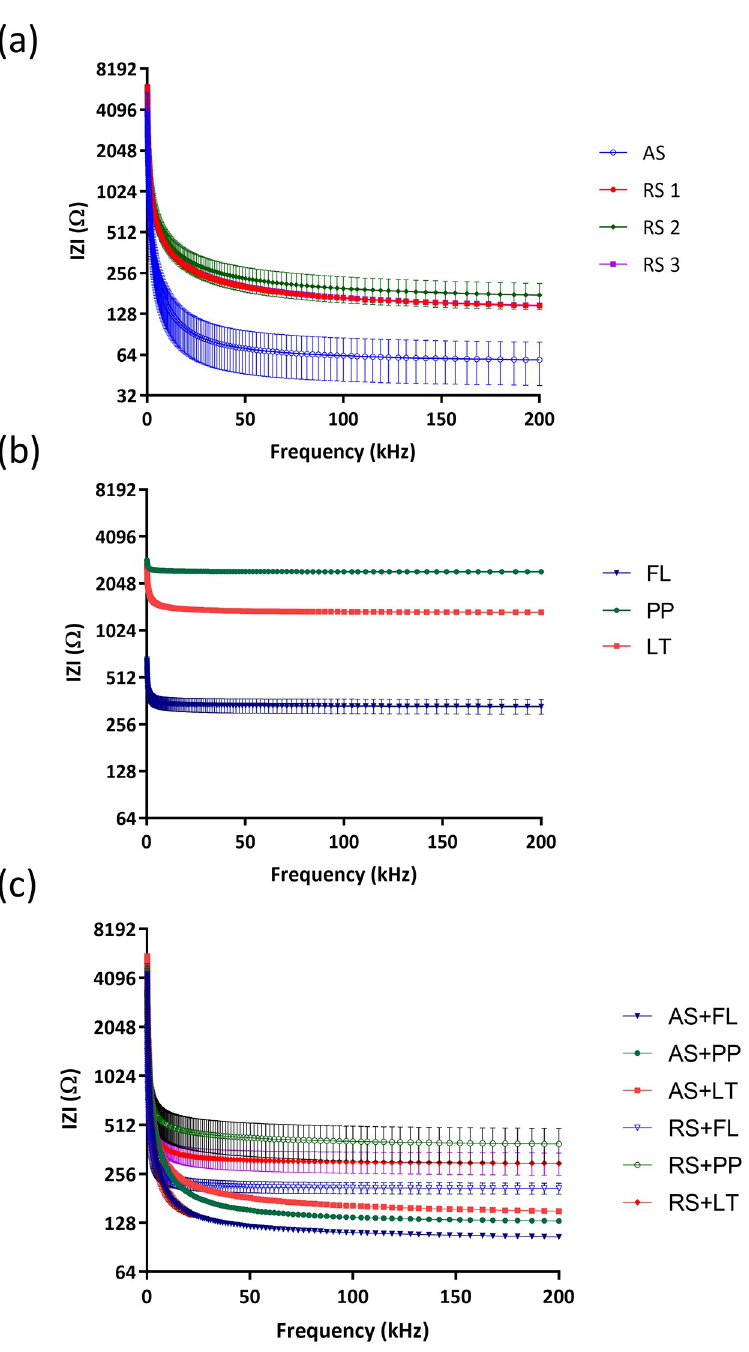
Fig 6. |Z| value of (a) real saliva (RS) and artificial saliva (AS), (b) chlorhexidine (PP)-, fluoride (FL)- and essential oil (LT)-based mouthwashes, and (c) mixed liquids. https://doi.org/10.1371/journal.pone.0280381.g006 Fig 6a–6c show the impedance response of saliva (artificial and real), mouthwashes and mixed liquids containing saliva (real or artificial) and different types of mouthwashes with respect to frequency. Impedance of real saliva is consistently higher than artificial saliva (Fig 6 (a)), although taken from the three different individuals. Fig 6(b) represents the impedance